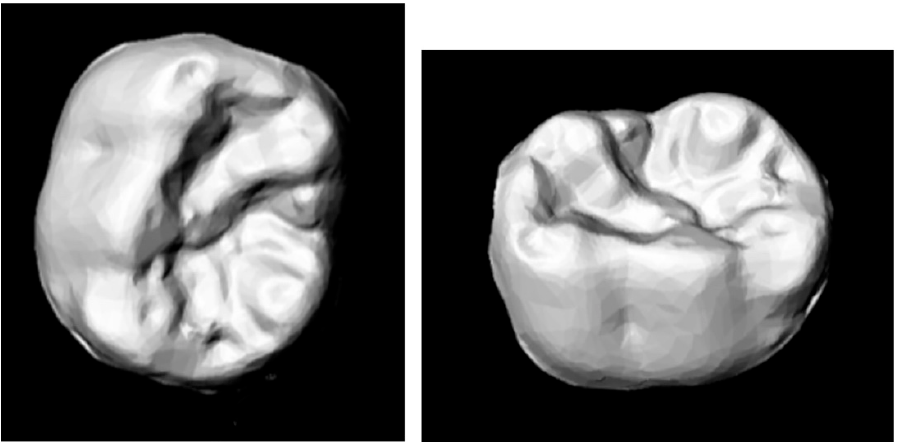
Figure 1. Digital reconstruction of the primary second lower molar.